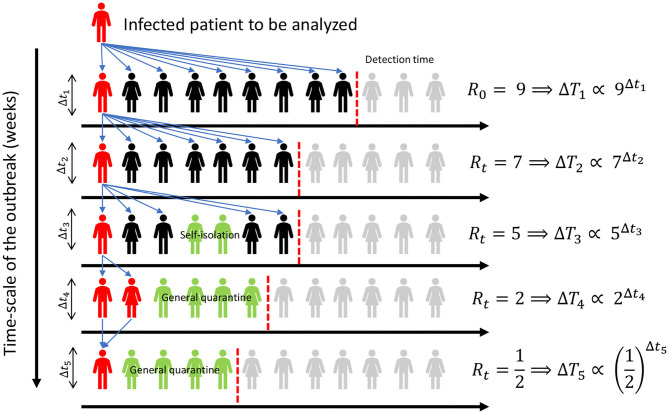
Different stages can be identified during the outbreak of an infection, characterized by the number of people that a single infected individual may infect. In the figure, a single infected individual (in red) can spread the virus among different individuals (in black), not reaching part of the population (in gray). Some individuals go into isolation (in green), effectively lowering their contagion chance. At the right-hand side of the plot, Rt represents the number of possible new infections caused by a single patient in each outbreak stage. In the first days of the outbreak, a single individual can infect several people before isolation, but as the amount of cases gets public awareness, health policies restricting movement and self-driven actions may help to control the outbreak, which is effectively captured by a decreasing Rt.